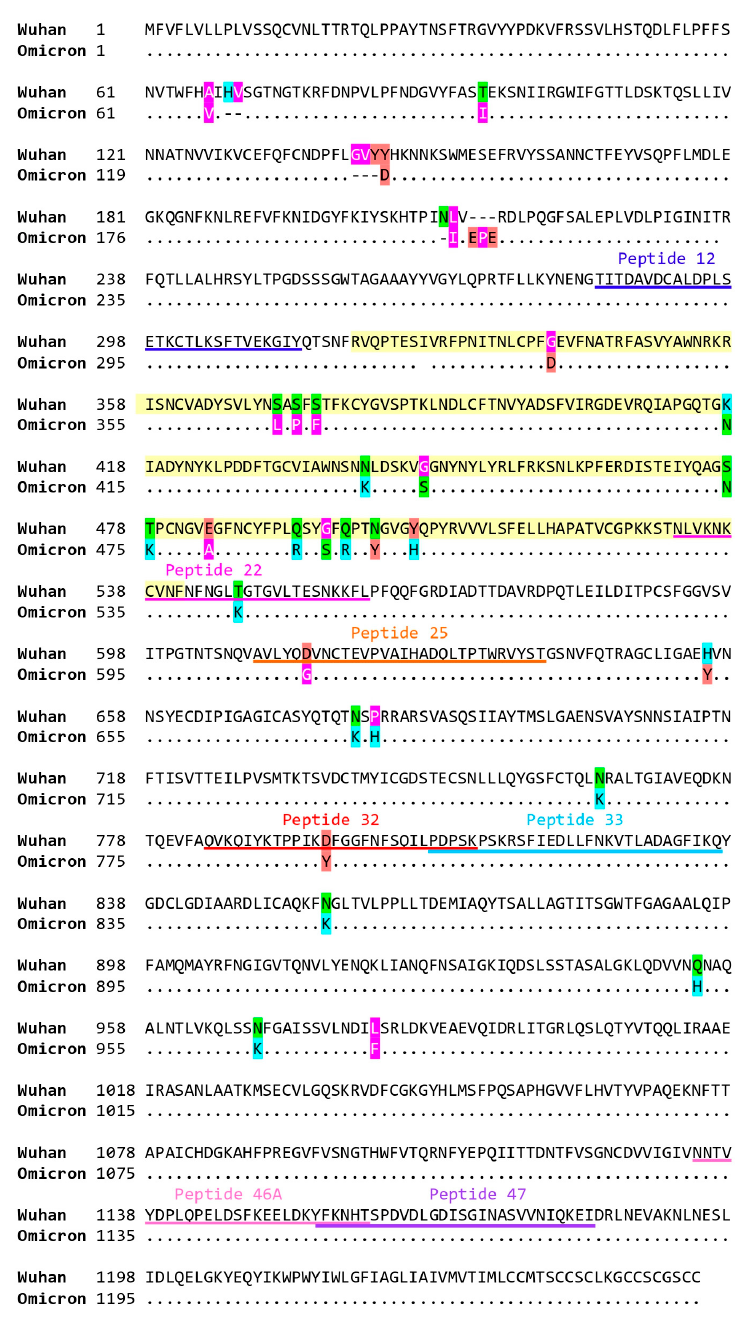
Figure 4. Protein sequence alignment of Wuhan-Hu-1 (top) and Omicron (below) of SARS-CoV-2 S-protein. RBD is colored in light yellow and peptides 12, 22, 25, 32, 33, 46A and 47 are underlined. Wuhan S-protein sequence corresponds to WA1 isolate (GeneBank accession Nr.: BCN86353.1), Omicron S-protein sequence Omicron is clade GRA, lineage B.1.1.529 BA.1 based on the GISAID data base (https://www.gisaid.org/ (accessed on 15 March 2022)). Amino acid substitutions are color-coded according to their hydropathy and charge properties (pink = hydrophobic, green = neutral, light blue = basic hydrophilic, and light red = acidic hydrophilic).